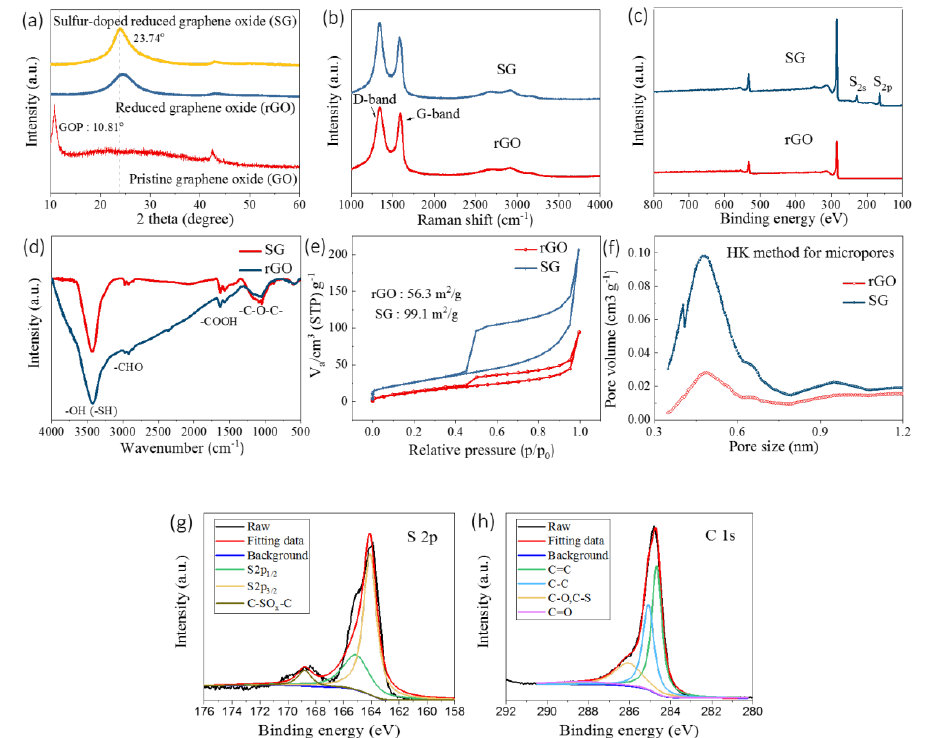
Figure 1. ( a ) X-ray di ff raction (XRD) patterns of pristine graphene oxide (GO) and sulfur-doped reduced graphene oxide (SG); ( b ) Raman spectra of reduced graphene oxide (rGO) and SG; ( c ) X-ray photoelectron spectrum (XPS) surveys; ( d ) Fourier-transformed infrared (FT-IR) spectra of rGO and SG; ( e ) N 2 absorption/desorption isotherms; ( f ) the corresponding pore size distributions of rGO and SG samples; ( g )High-resolutionS2pX-rayphotoelectronspectrum(XPS)spectrum; and ( h ) high-resolution C 1s XPS spectrum of